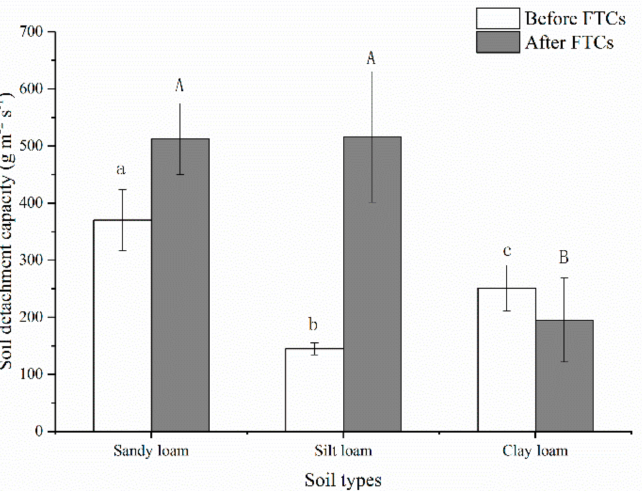
Figure 8. Soil detachment capacities before and after freeze-thaw cycles of three soils. Note: The letters indicated whether the differences in the test results were significant or not. “a, b, c” stands for before freeze-thaw cycles (FTCs), “A, B” stands for after freeze-thaw cycles. Different letters indicate a significant difference of test results among the different freeze-thaw cycles and soils at the 0.05